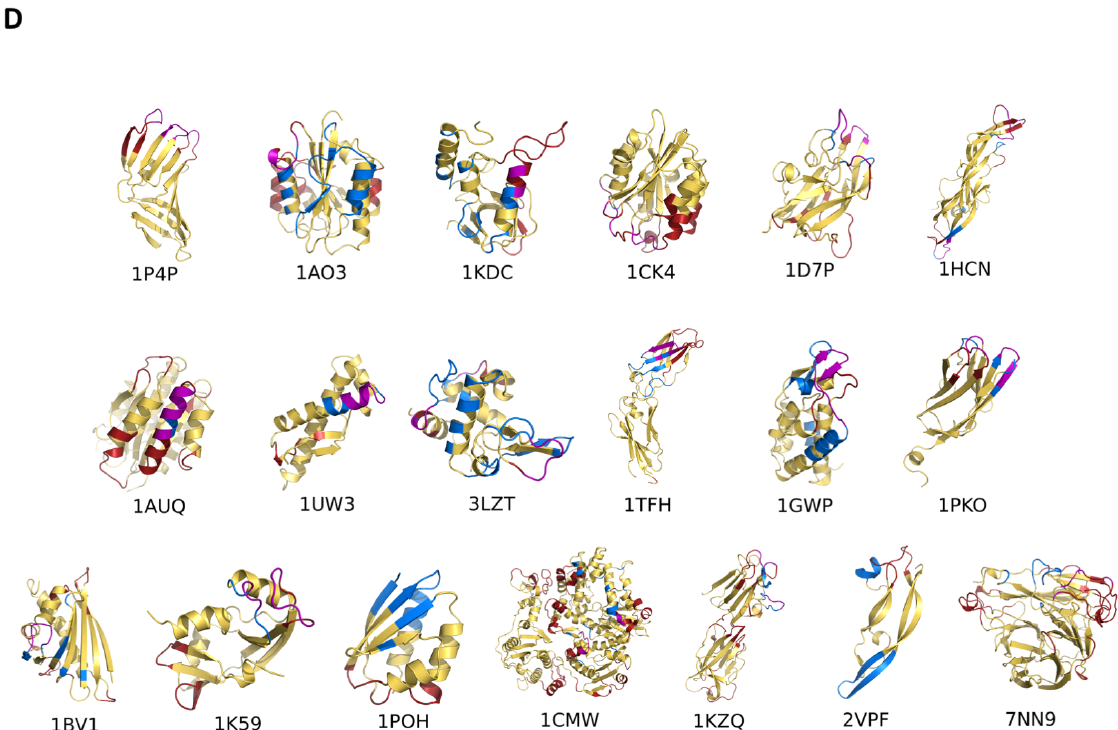
Figure 1. Structure and energy-based strategy for the prediction of antibody binding regions from protein antigen structures. ( A ) Definition of the epitope region on a protein antigen prone to engage an antibody; ( B ) energy-based separation of the folding core and interaction regions in antigens; ( C ) matrix of low coupling energies (MLCE) strategy; ( D ) epitope prediction and benchmark on a number of proteins extracted from the Protein Data